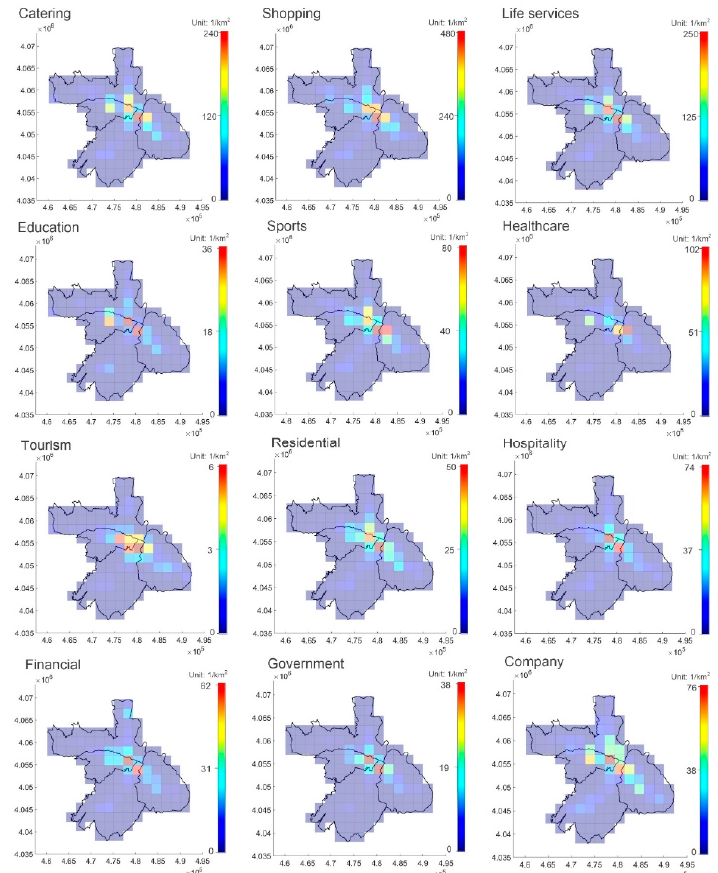
Figure 5. Distribution of 12 categories of points of interests (POI) in Xining City.